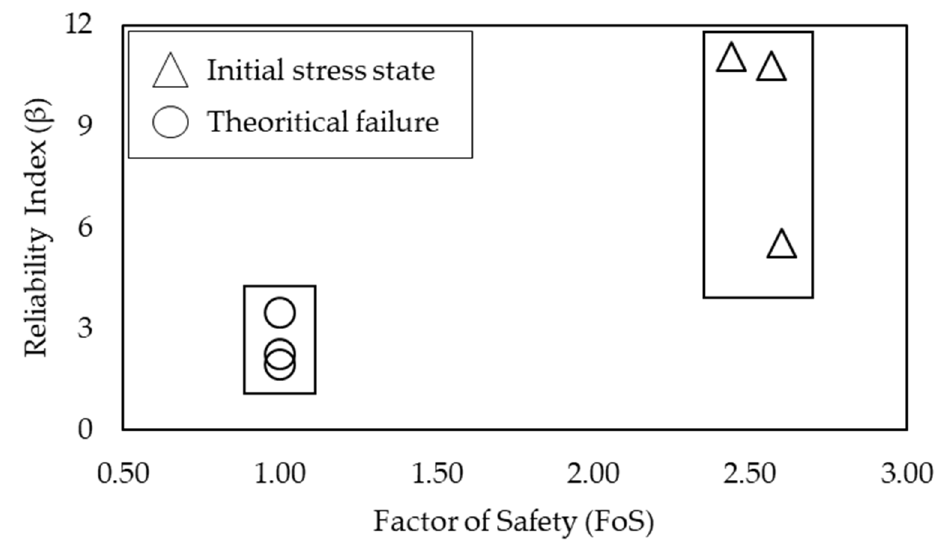
Figure 12. The cross plot of Draupne and Drake caprock shales illustrated the difference between probabilistic and deterministic safety factors in the initial stress-state and theoretical failure condi- tion.